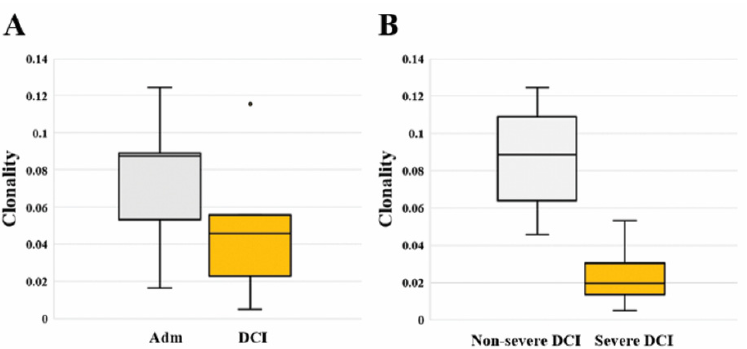
Figure 1. ( A ) Comparison of TCRB clonality between the two different time periods of the day of admission (Adm) and delayed cerebral ischemia (DCI). Clonality did not differ significantly between admission [0.088 (0.053–0.089)] and DCI [0.046 (0.023–0.056); p value = 0.421]. ( B ) Comparison of TCRB clonality between severe DCI and non-severe DCI. Clonality of severe DCI patients [0.020 (0.014– 0.030)] was significantly higher than that of non-severe DCI patients [0.088 (0.064–0.109; p value = 0.019].